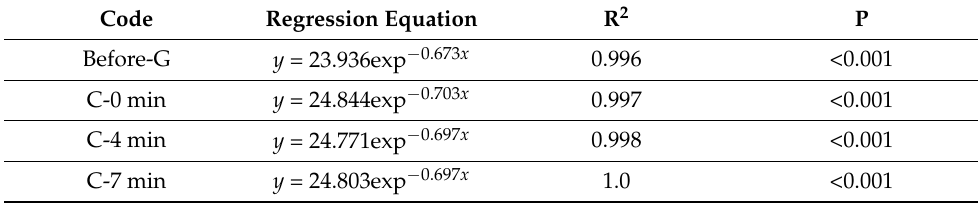
Table 7. Regression analysis of the relationship between TP and thickness in each group.